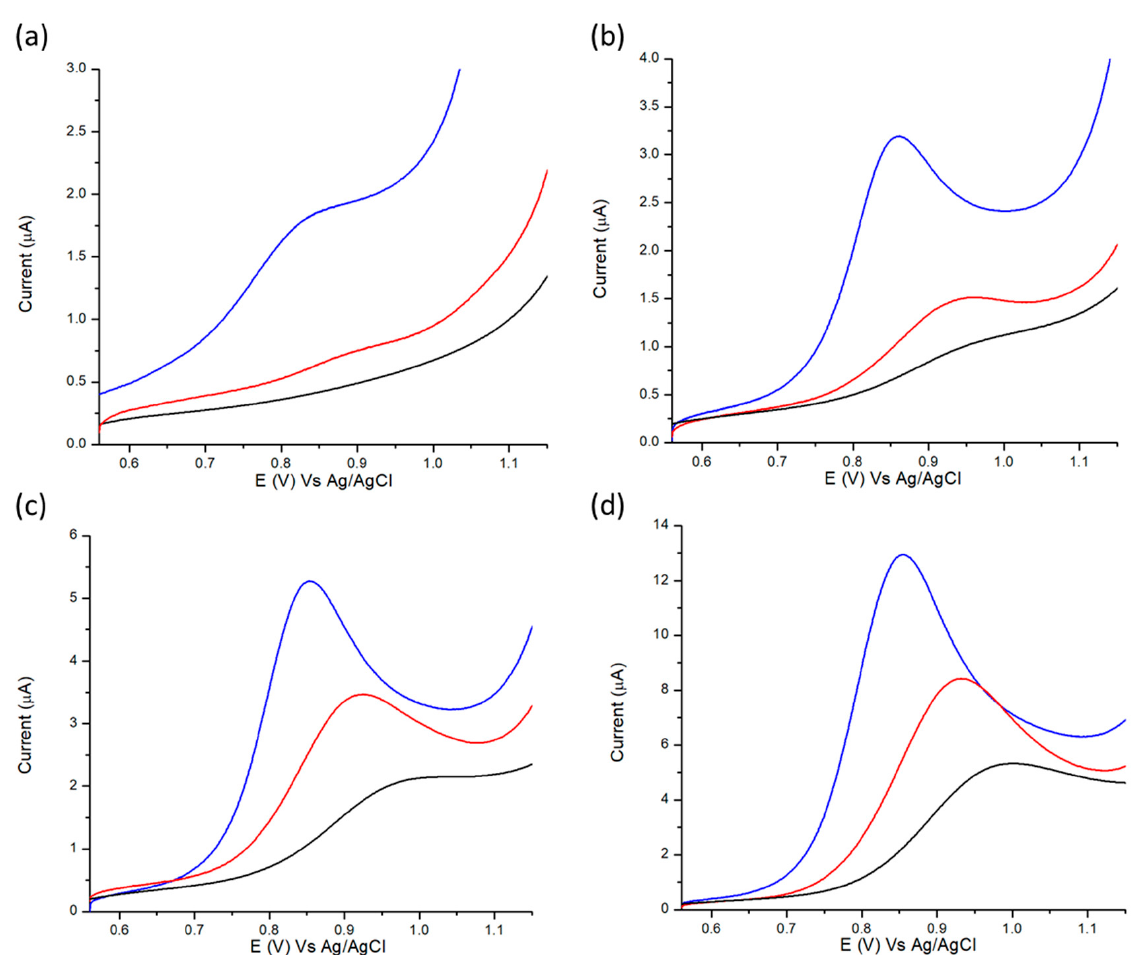
Figure 1. CVs of bare GCE (black line), HMT-PMBI (red line), and HMT-PMBI/NGNP (blue line) coated electrodes recorded at different concentrations of nitrites: ( a ) 1 µ M, ( b ) 10 µ M, ( c ) 30 µ M, and ( d ) 100 µ M. The supporting electrolyte was 0.1 M NaCl and scan rate was 0.1 V s − 1 .